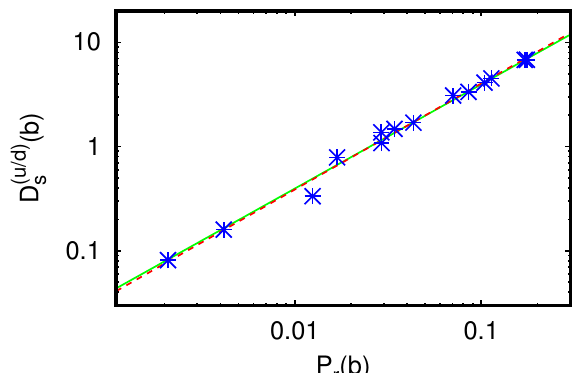
( u/d ) ( b ) from Table 3 on the (local) PageRank s ( u/d ) ( b ) = η P r ( b ) with the s